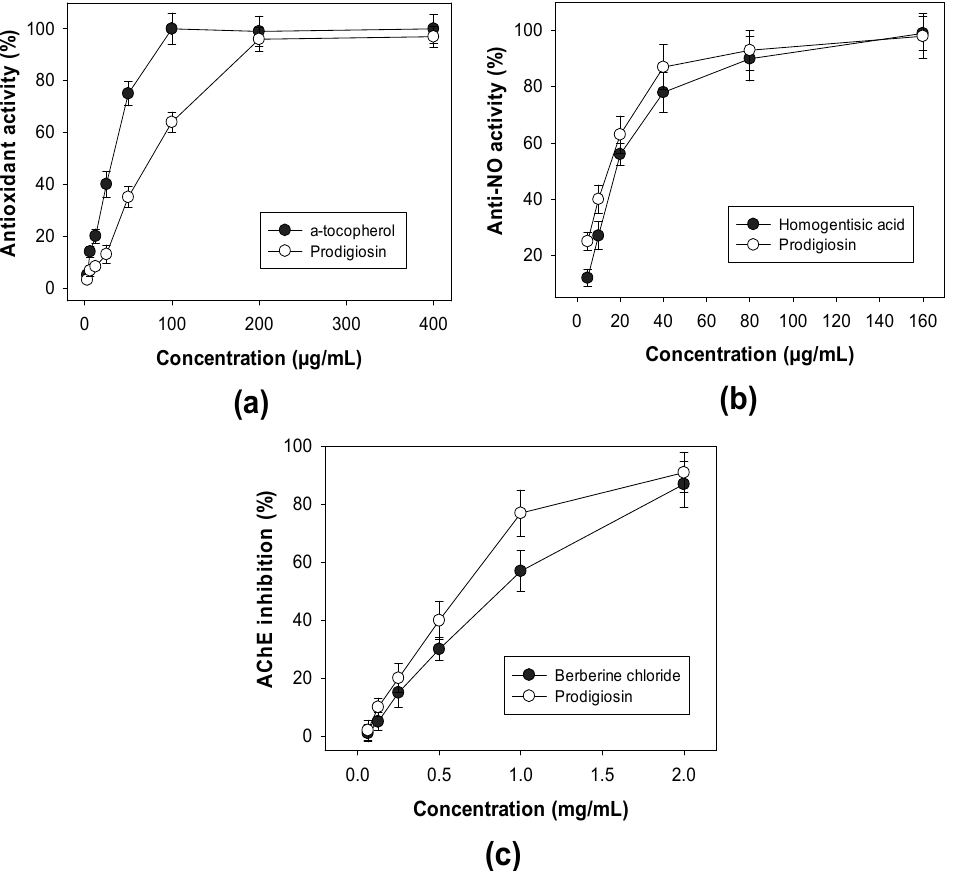
Figure 6. Bioactivities of prodigiosin (PG) including antioxidant activity ( a ), anti-NO activity ( b ), and acetylcholinesterase (AChE) inhibitory activity ( c ). Standard errors (SE) are shown as error bars in all the